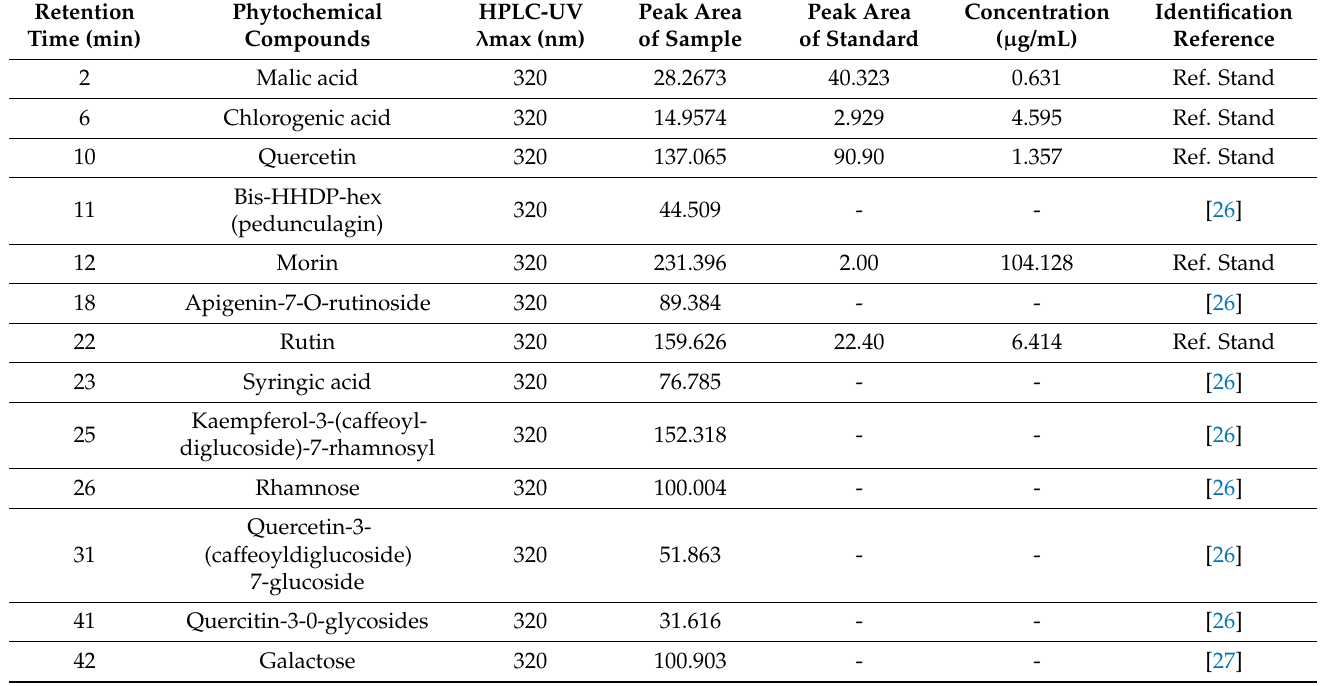
Table 7. Identified phytochemicals in n -hexane fraction of A. articulata through the HPLC-UV